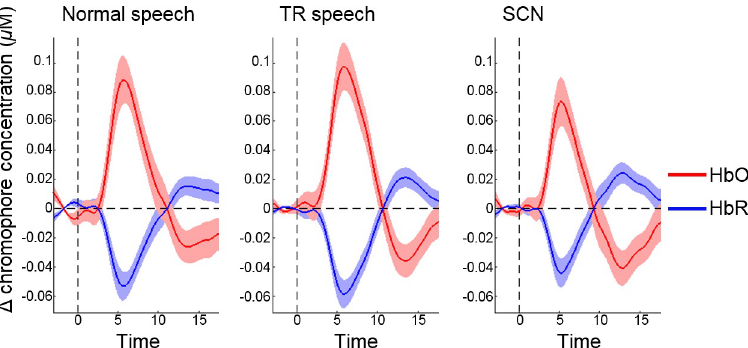
Fig 3. Block-averaged haemodynamic time courses. These are displayed for each type of auditory stimulus (response to silent trials subtracted out). Responses were averaged across channels 28, 29 and 33 (left hemisphere) and channels 7, 10 and 11 (right hemisphere) targeting the superior temporal